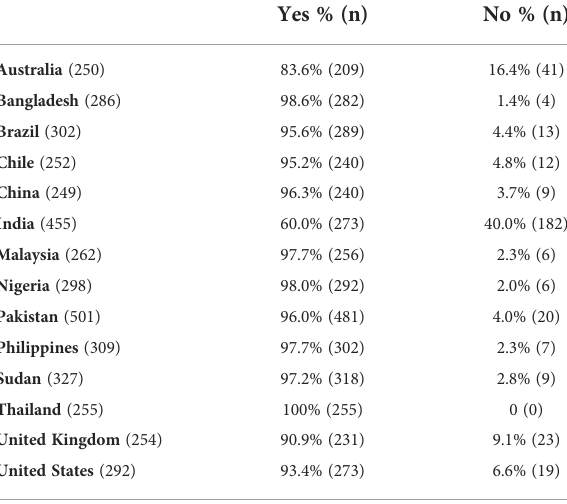
TABLE 1 Percentage of respondents who consume eggs, by